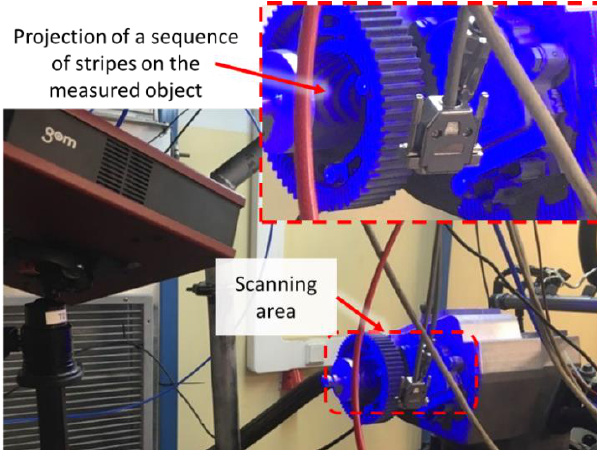
Fig. 9. Projection of a sequence of stripes on the measured